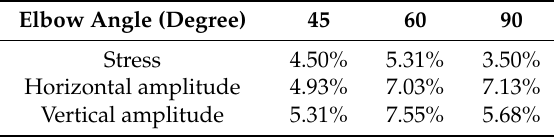
Figure 12. Relative error of the experimental and numerical simulation results: ( a ) stress; ( b ) horizontal amplitude; ( c ) vertical amplitude. Table 3. Calculation results of average relative error.